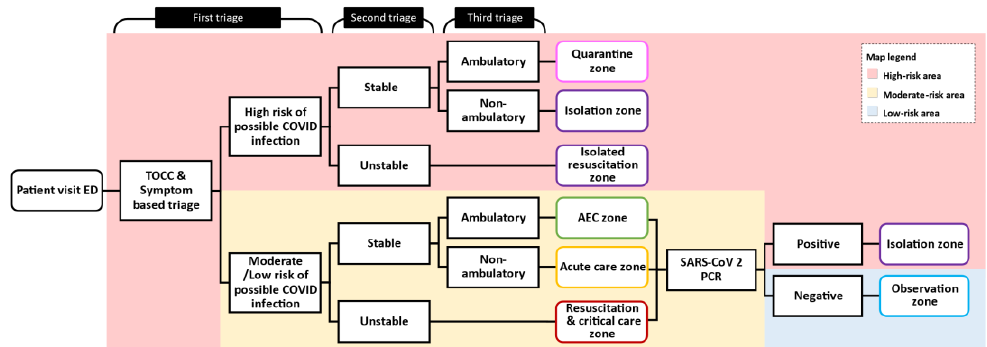
Figure 2. Patient flow and protocol. We modified a triple triage protocol to stratify patients’ risks of COVID-19 infection and diverted them into different areas accordingly. Abbreviations: Acute emergency care zone (AEC).